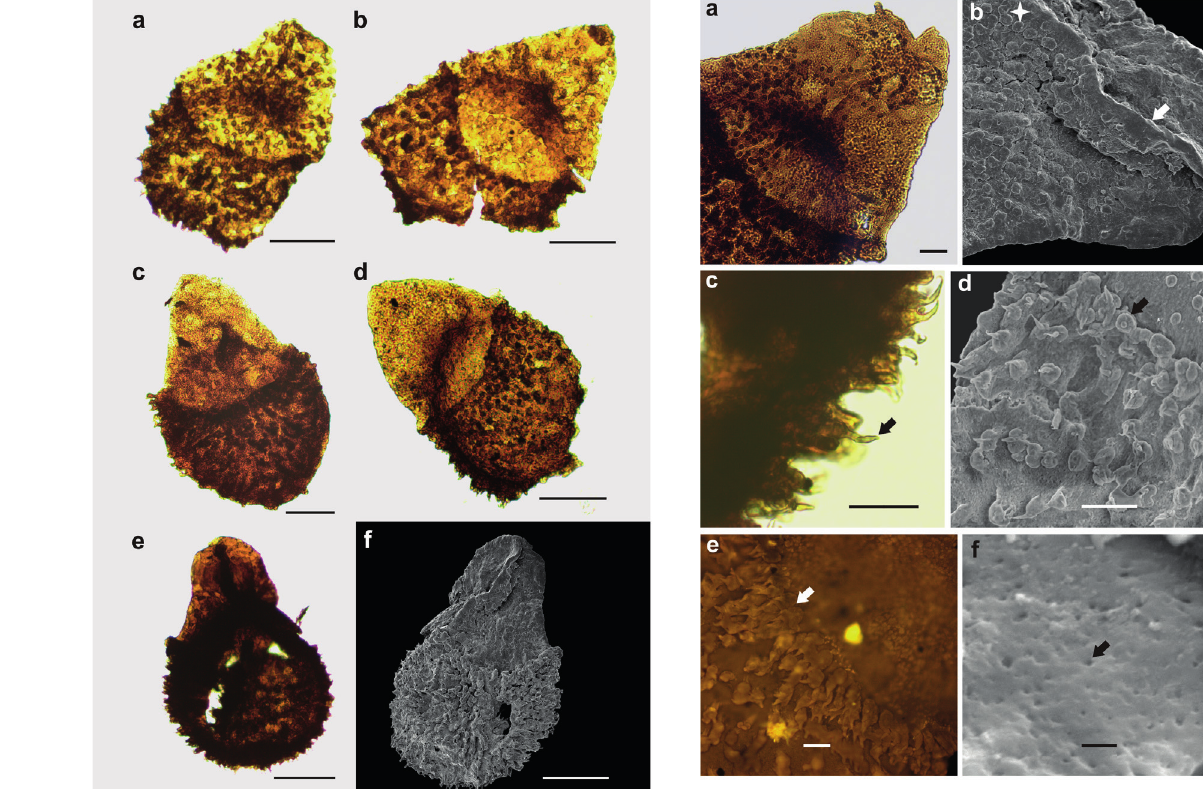
Figure 3 - Lagenoisporites magnus . Surface details. a - f. a: Specimen CICYttP-M 380. Verrucae of the gula (LM). Scale bar: 40 μm. b: Specimen CICYttP-M 162. Ornamentation of verrucae and laesurae lips (arrow) of the gula (SEM). Note that some verrucae are fused together (star). Scale bar: 20 μm. c: Specimen CICYttP-M 162. Detail of the complex processes of the spore body, formed by a bulbous base and an internally partitioned projection (arrow) with sharp apex (LM). Scale bar: 20 μm. d: Specimen CICYttP-M 428. Complex processes of the spore body and detail of the curvaturae perfectae surface (arrow; SEM). Scale bar: 20 μm. e: Specimen CICYttP-M 144. Complex processes of the spore body and detail of the curvaturae perfectae surface (arrow) observed with fluorescence LM. Scale bar: 20 μm. f: Specimen CICYttP-M 162. Detail of the spore body surface that shows perforations (arrow; SEM). Scale bar: 2